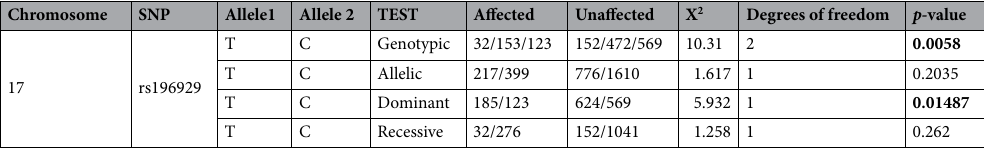
Table 1. Results from the genotypic analysis of patients diagnosed with all types of cancer and the rs196929 variant (bold indicates statistically significant p -values under the threshold 0.05). Assuming that D is the minor allele and d is the major allele, the allelic model compares the frequencies of each allele in each group (D x d), the genotypic model is an additive two degree of freedom model that compares the frequencies of each genotype in the groups (DD x Dd x dd), the dominant model compares the two copies of the common allele frequency versus the other combinations (dd x DD + Dd), and the recessive model compares the two copies of the rare allele frequency versus the other combinations (DD x Dd + dd). X 2 , Chi-square value.